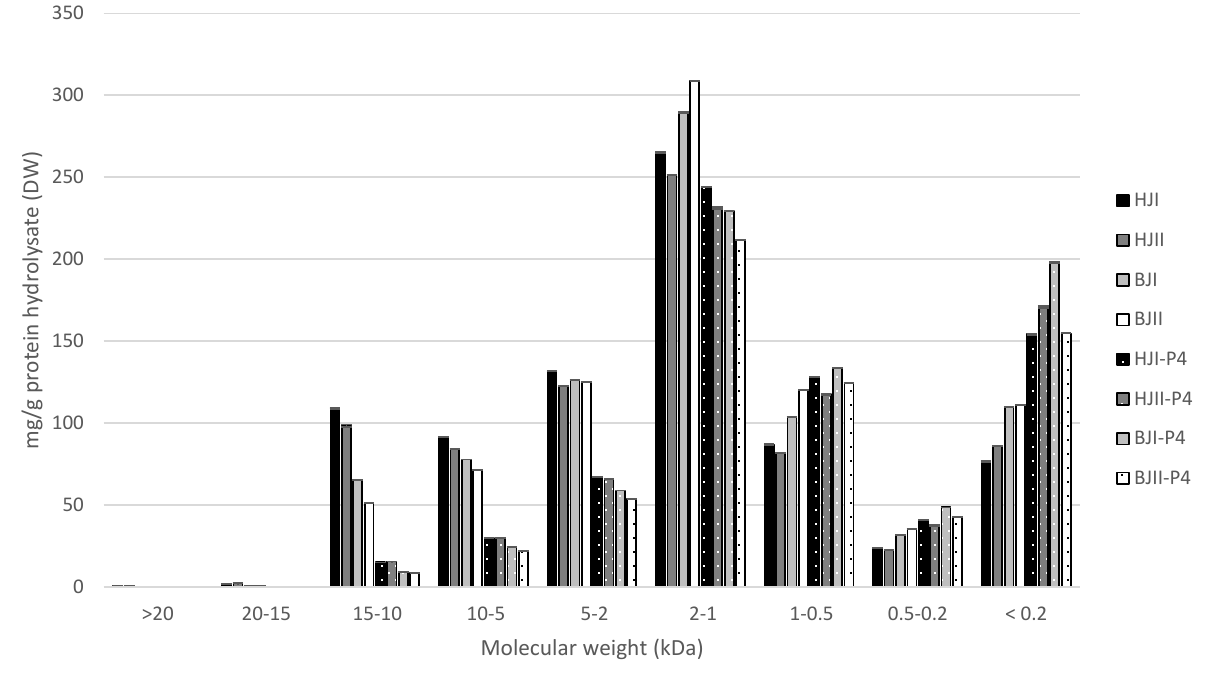
Figure 6. Molecular weight distribution (x ± SEM, n = 2) of saithe protein hydrolysates (SPH) (HJI, HJII, BJII, BJII) and their corresponding permeates (HJI-P4, HJII-P4, BJI-P4, BJII-P4) after ultrafiltration (<4 kDa). SPH were obtained from enzymatic hydrolysis of heads (H) and backbones (B), in two bioreactors (I, II), from saithe caught in January 2020 (HJI, HJII, BJI,